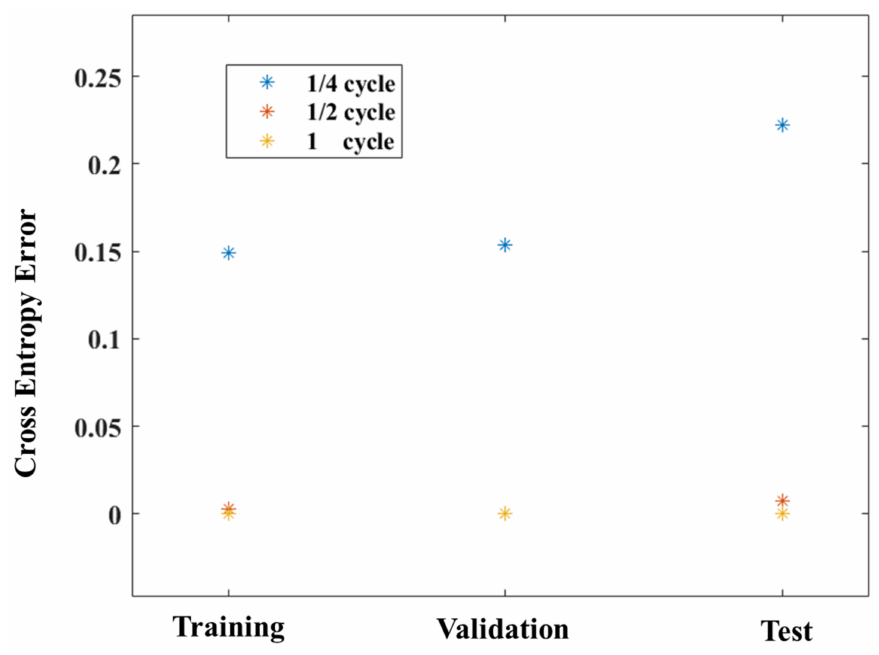
Figure 19. Fault type CEE.